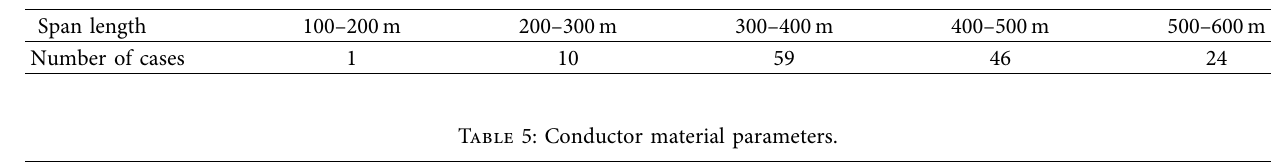
Table 4: The range of span length.